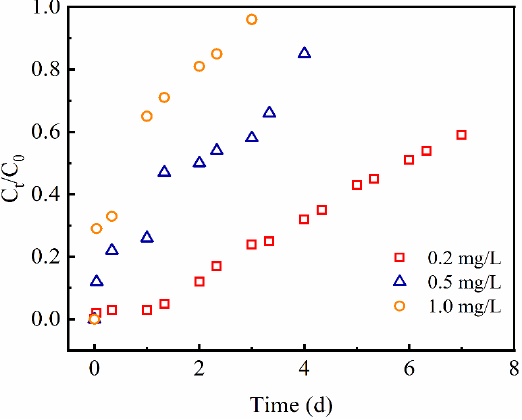
Figure 9. Effect of influent solution concentration on TCS breakthrough curve.